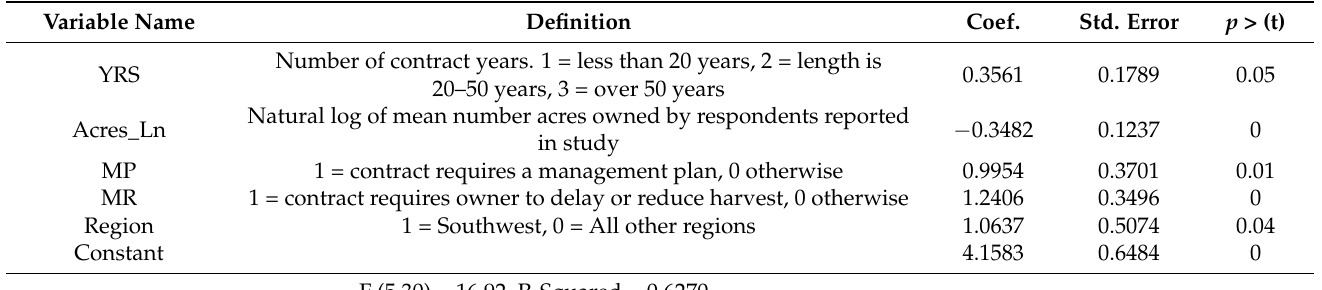
Table 3. Robust regression of forest owner WTA for carbon sequestration in private forests.